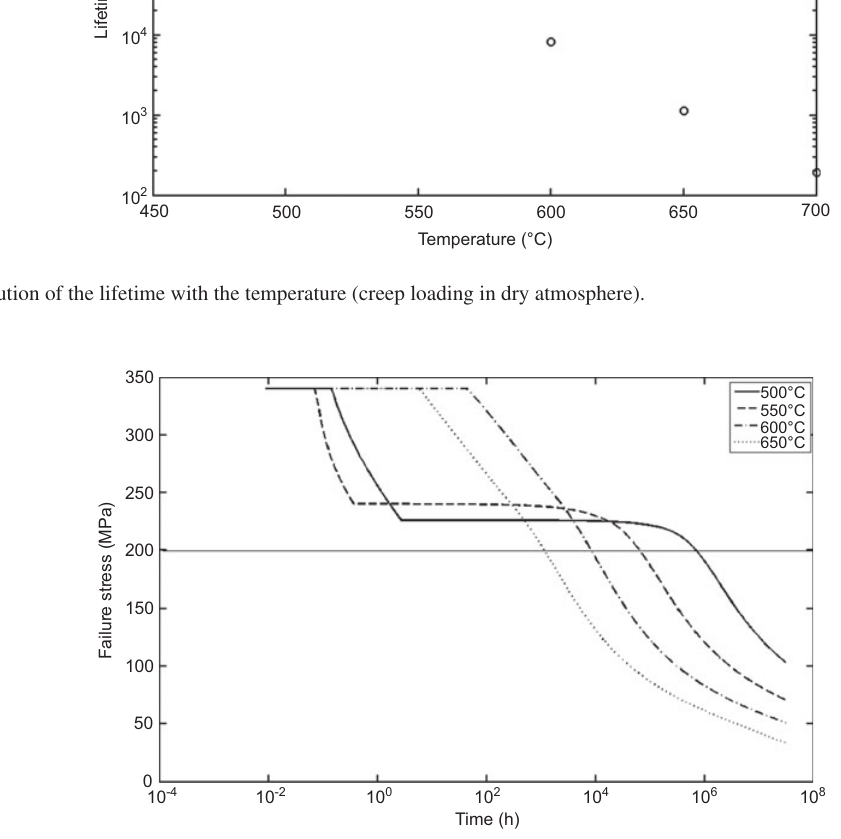
Figure 4 Failure stress as a function of time (creep